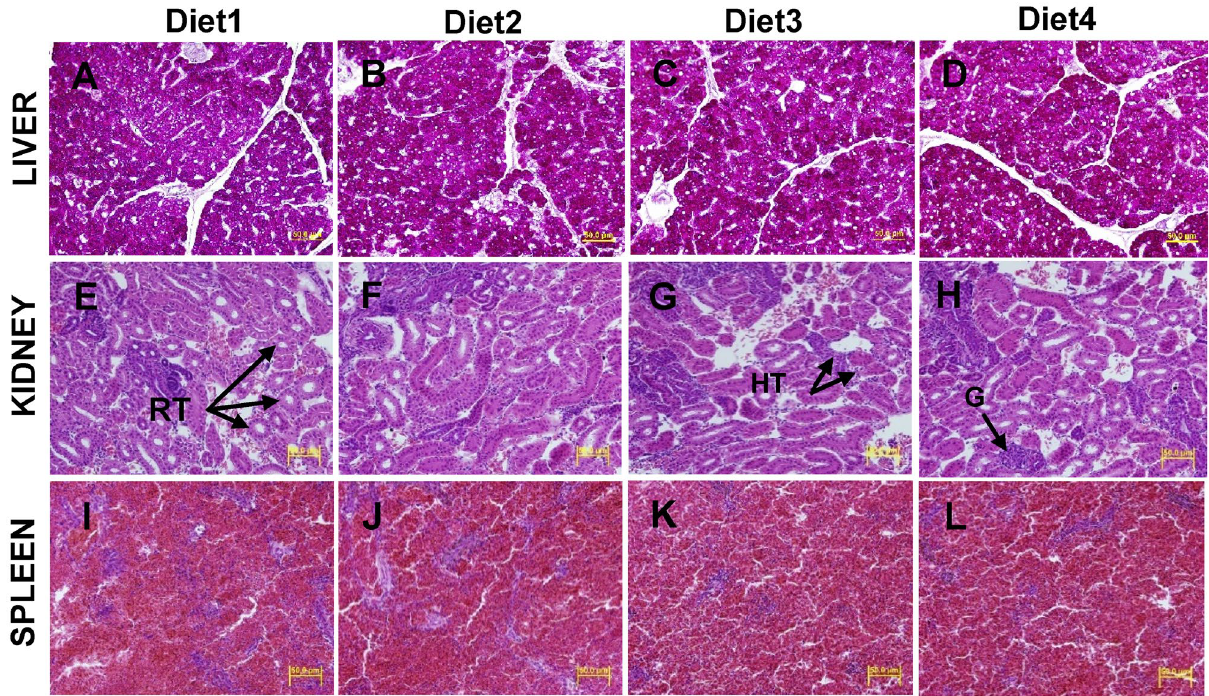
Figure 1. Representative micrographs of staining liver ( A – D ), kidney ( E – H ) and spleen ( I – L ) sections of barramundi fed control (Diet1),